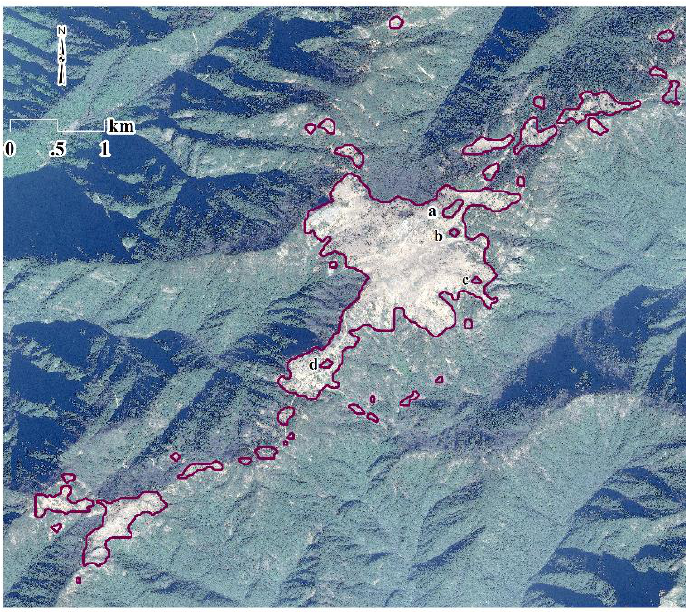
Figure 8. Cross-comparison between the tree line extracted from Landsat and RGB images (dark red) from a Landsat TM image acquired on 20 December 2014 ( a – d are four tree islands from extracted results within the alpine meadow, with areas of 17,843.35, 4292.55, 3368.89, and 6158.43 m 2 , respectively). Background is an RGB image (true color composition) with a 0.53 × 0.53 m spatial resolution downloaded from Google Earth.